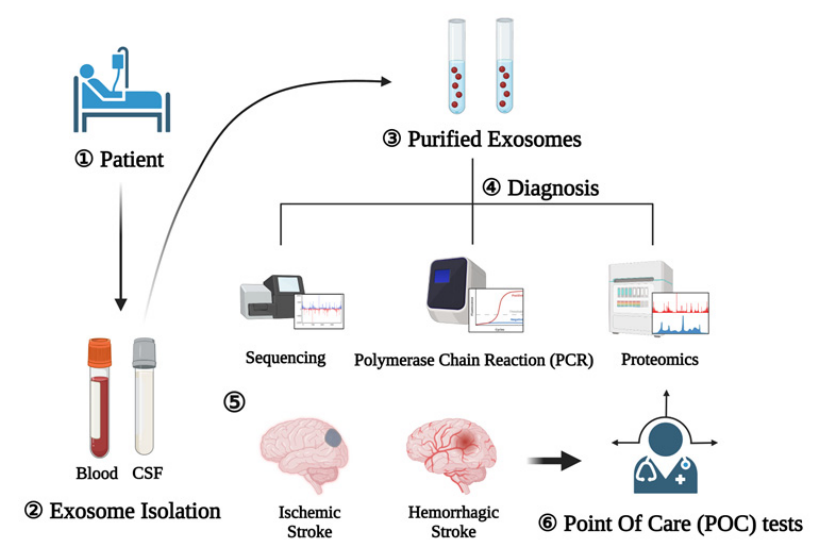
Figure 3. Exosomes as diagnostic markers (1). Blood and CSF are collected after the patient develops (2). After that, exosomes are extracted (3) and diagnosis is performed through sequencing, polymerase chain reaction, and proteomics (4). Schematic representation of the procedure for using exosomes as diagnostic markers for the rapid diagnosis of ischemic and hemorrhagic strokes (5). Afterwards, the point of care test can reduce the time by explaining the on-site diagnosis result to the patient (6). Therefore, to predict the cause and severity of stroke in the future, it would be crucial to re-evaluate the sensitivity and specificity of these biomarkers and use exosomes to discover completely new